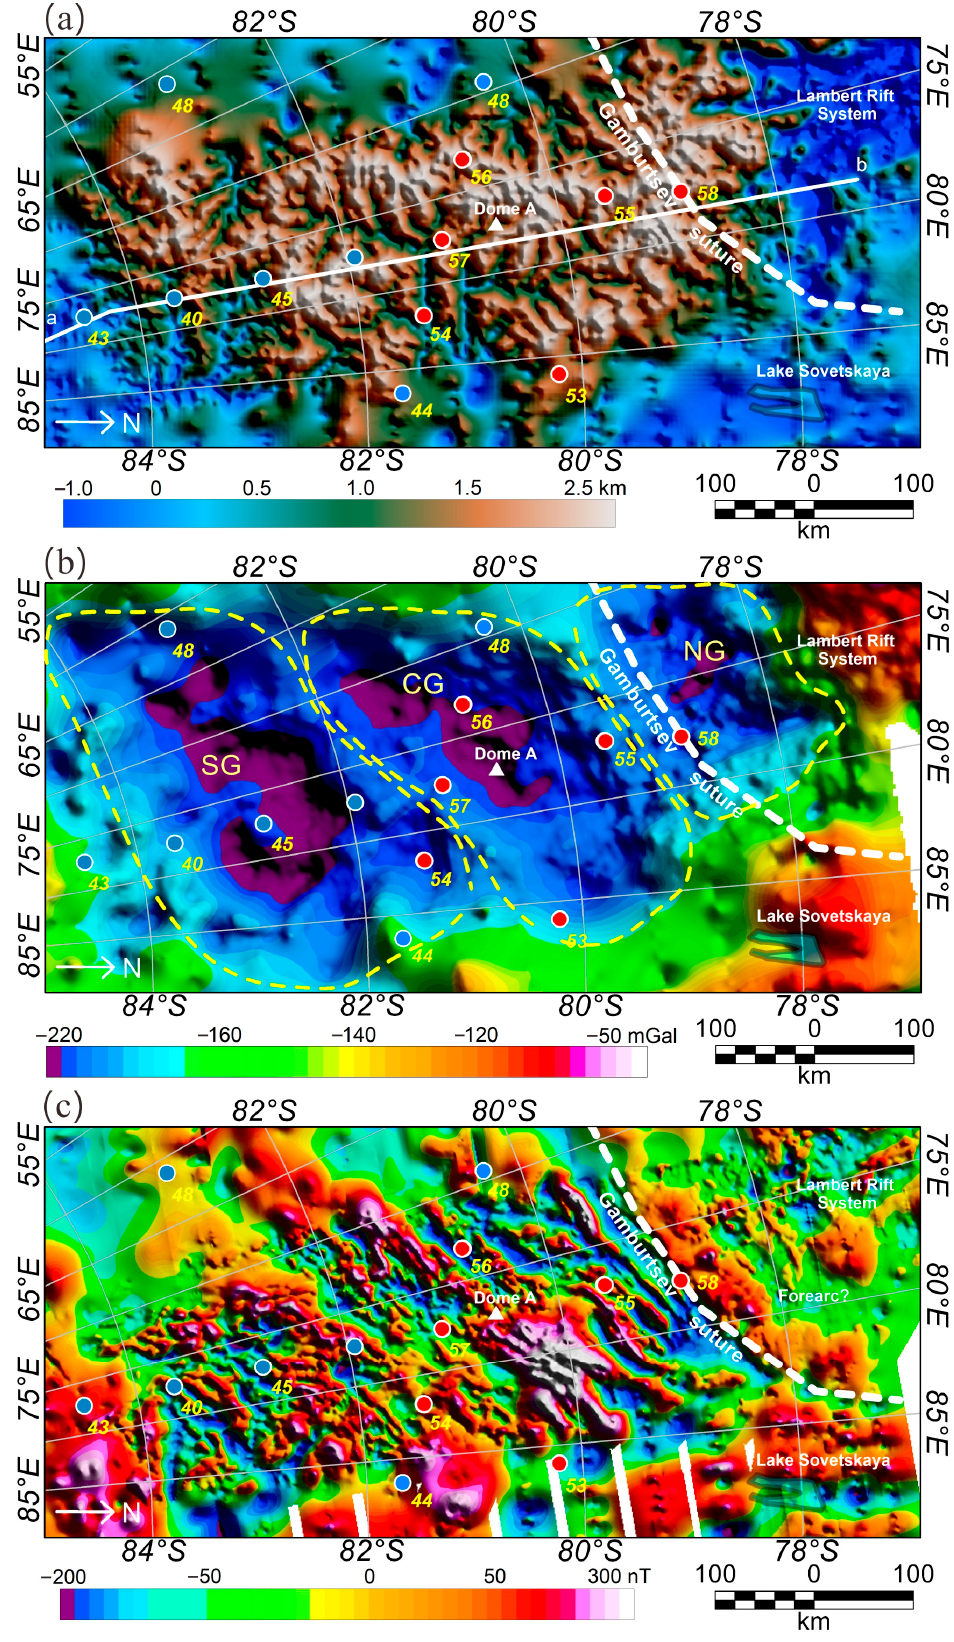
Figure 2. Airborne geophysical data over the GSMs. ( a ) Subglacial bedrock elevation of the GSMs. ( b ) Bouguer Gravity map. The height of Bouguer gravity anomaly has been reduced to 4600 m